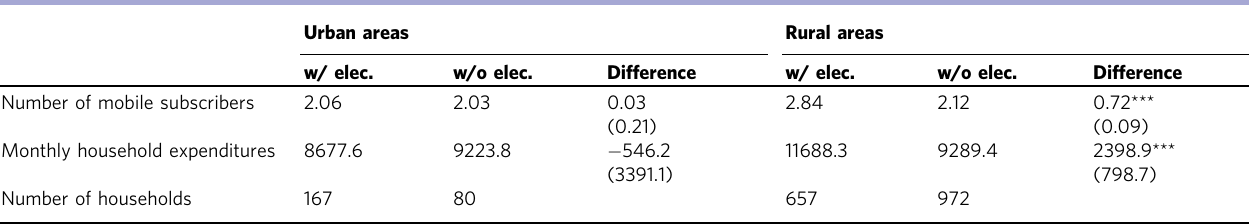
Table 5 Mobile subscription and expenditures-propensity score matching